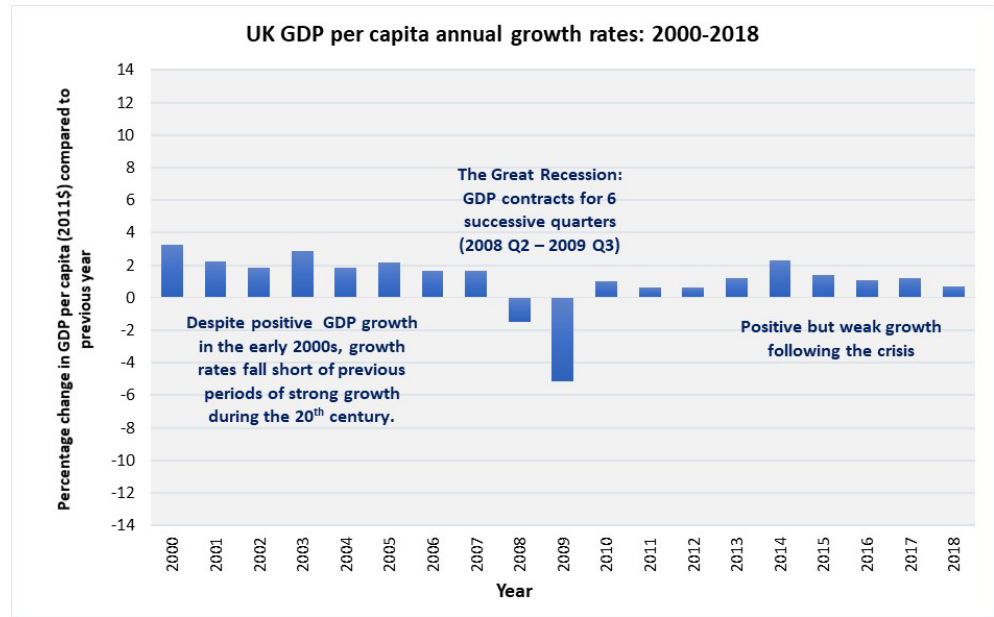
Figure 7. Annual growth rates as the UK entered and exited the Financial Crisis and subsequent recession. Before the crisis, growth rates lagged behind previous strong performance in the 20th century. The trend of weak productivity has marked the period since the crisis (see Note